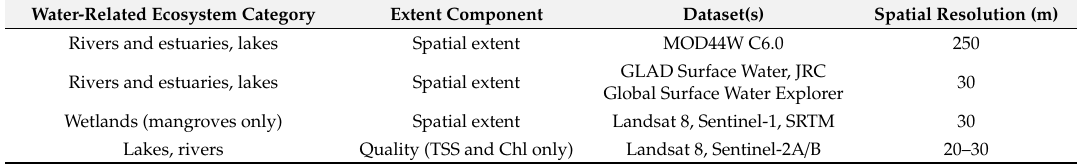
Table 2. Summary of the components measured and datasets used in this study. Note: Copernicus Sentinel data are processed by the European Space Agency and were retrieved in 2017 for this